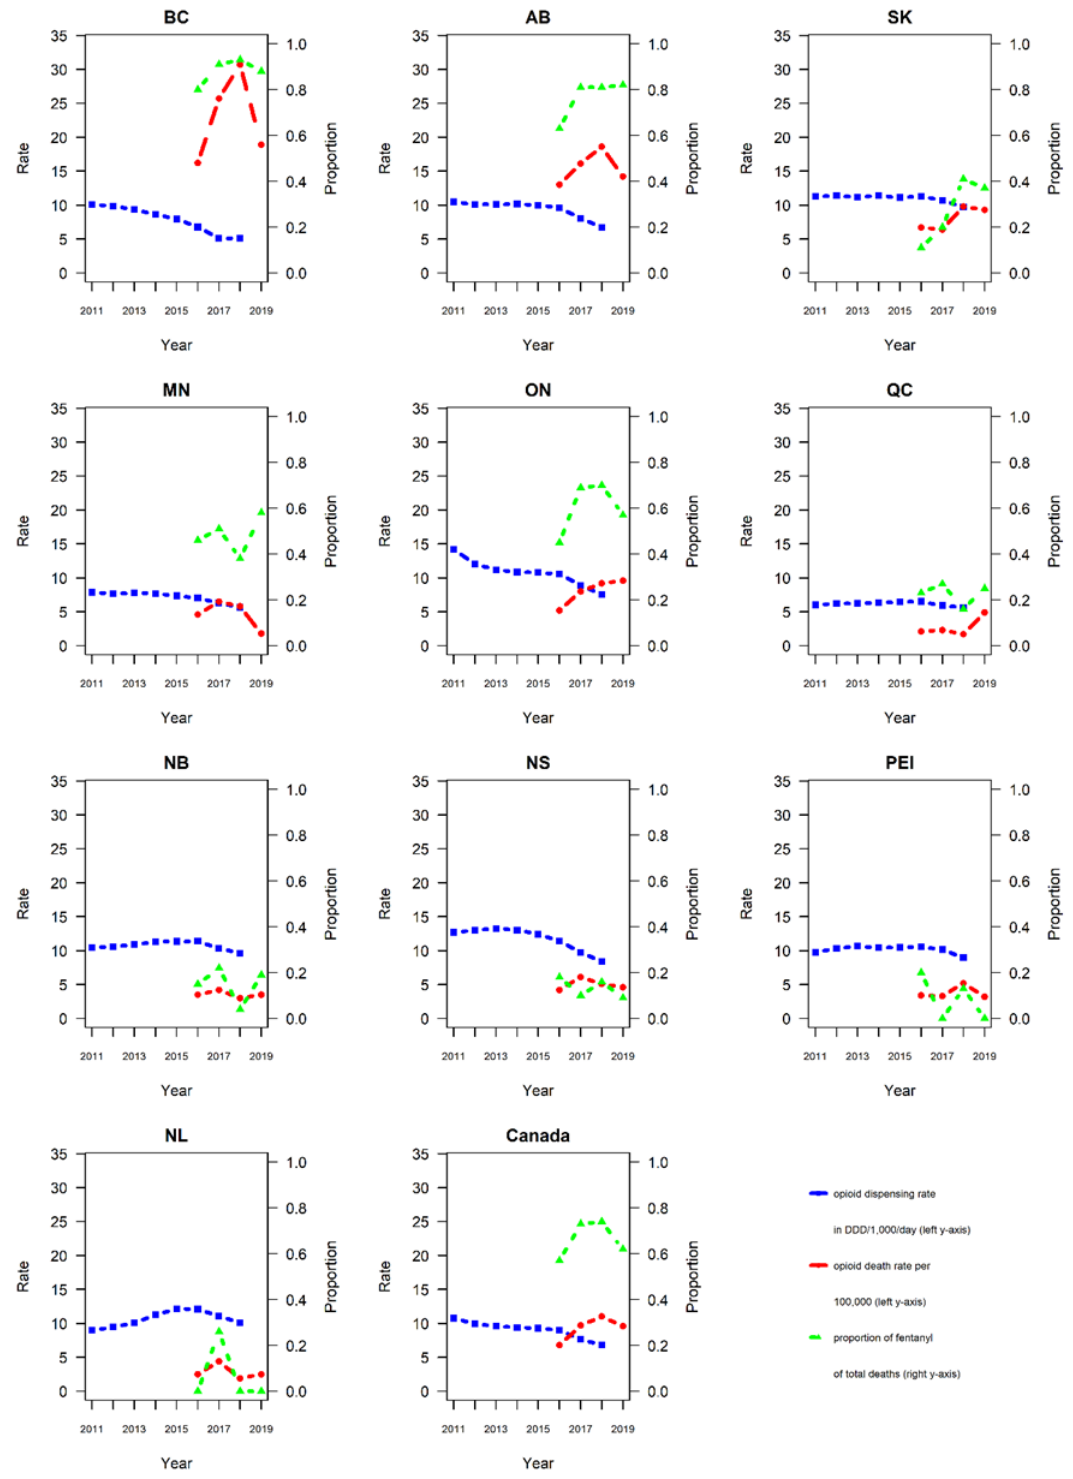
Figure 1. Annual rates of opioid dispensing and opioid-related mortality, and proportion of fentanyl among opioid-related deaths, for provinces and Canada total (for abbreviations of provinces see Table 1).